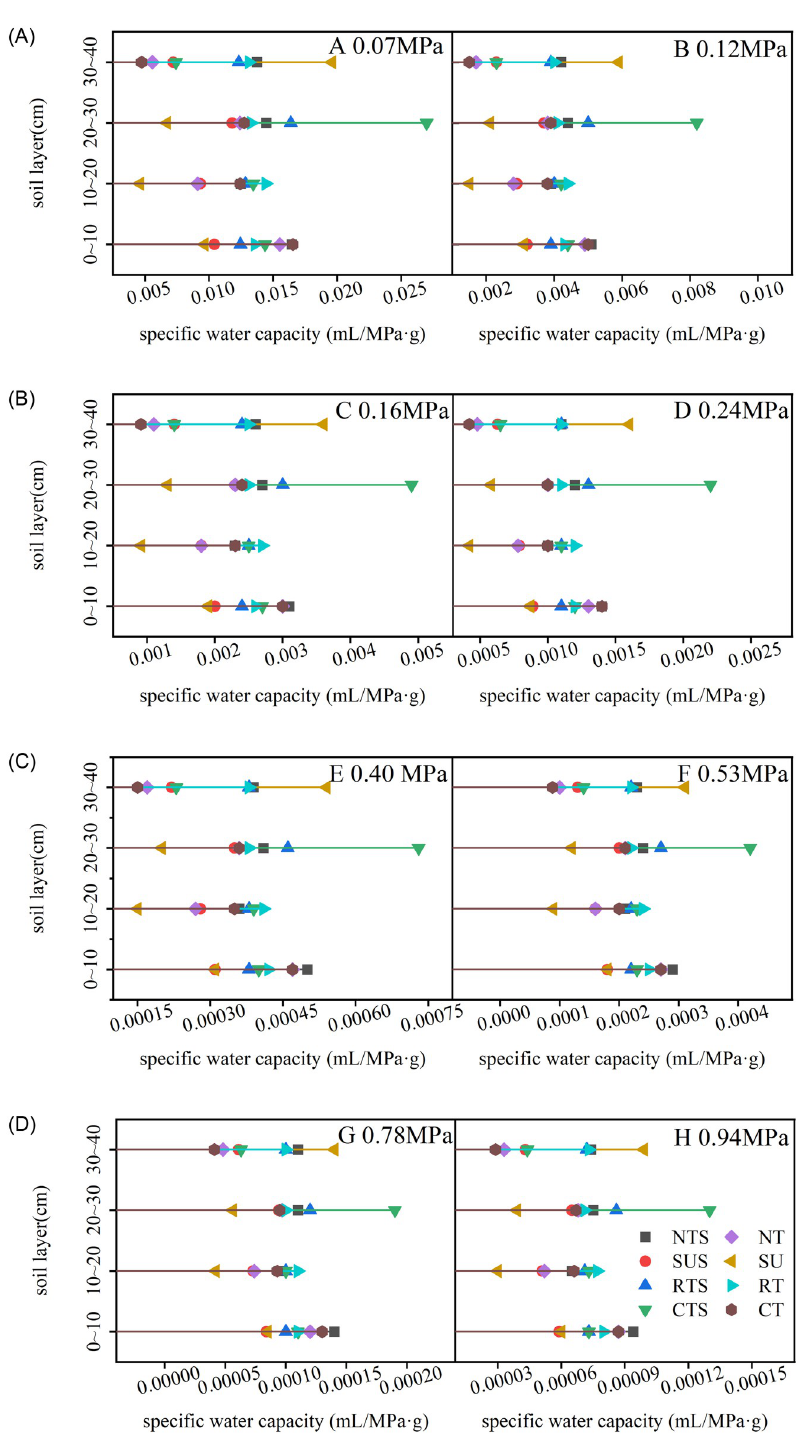
Fig 6. Soil specific water capacity of different soil layers under different tillage cultivations at different soil water suction levels. Note : At the same soil suction, the larger the specific water capacity, the stronger the water supply capacity. NT, no–tillage; SU, subsoiling; RT, rotary tillage; CT, conventional tillage; NTS, no–tillage and straw; SUS, subsoiling and straw; SUS, subsoiling and straw; RTS, rotary tillage and straw; CTS, conventional tillage and straw.